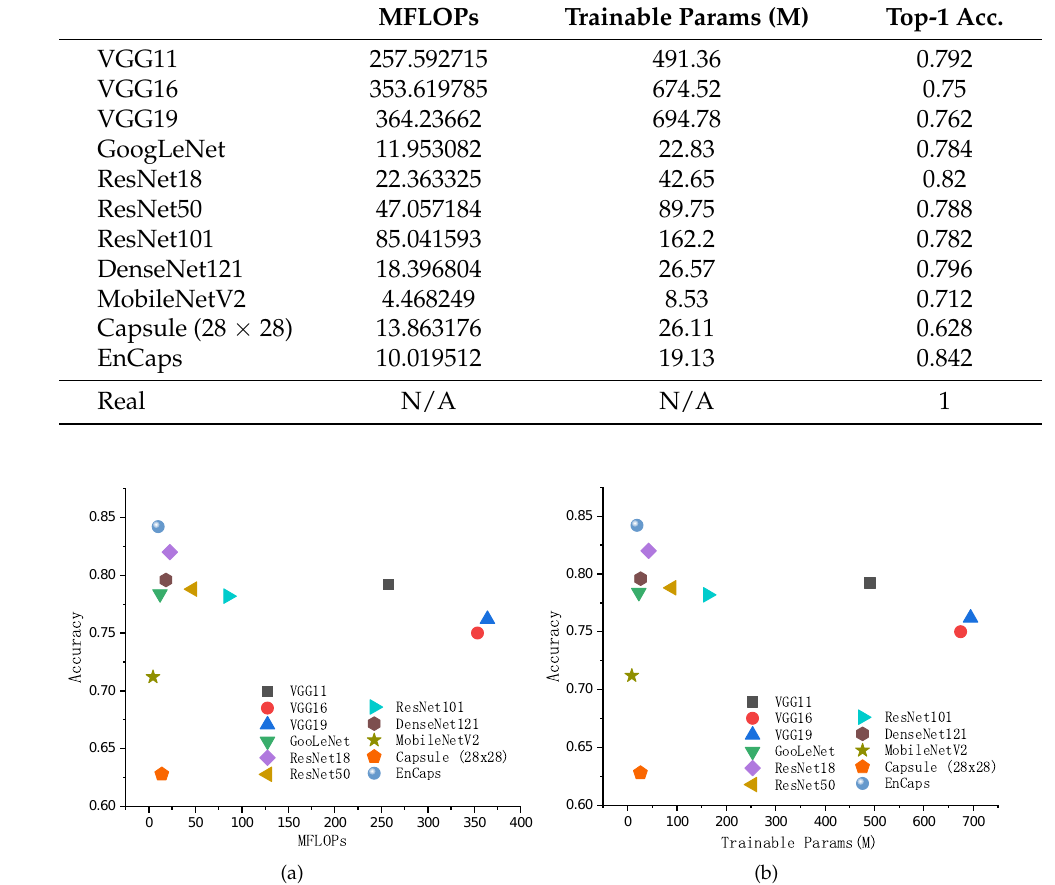
Figure 9. The comparison of calculation, parameter, and accuracy between different networks. ( a ) the comparison of MFLOPs; ( b ) the comparison of trainable